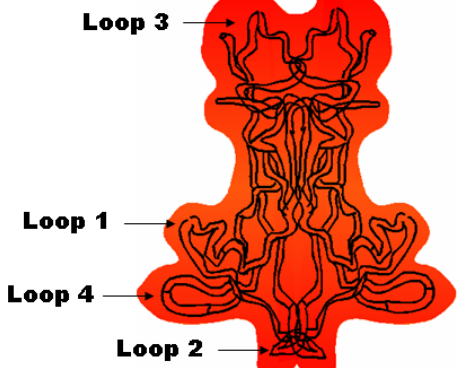
Figure 1. Schematic presentation of a neurotrophin (brain-derived neurotrophic factor (BDNF)) dimer with designation of the four loops participating in receptor recognition and